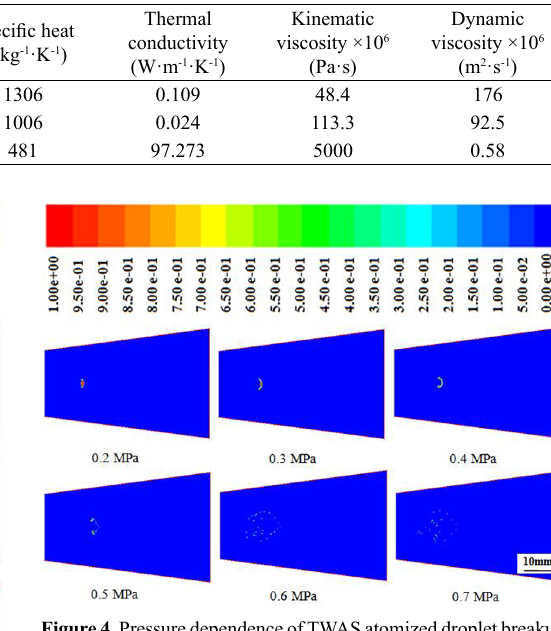
Figure 4. Pressure dependence of TWAS atomized droplet breakup process